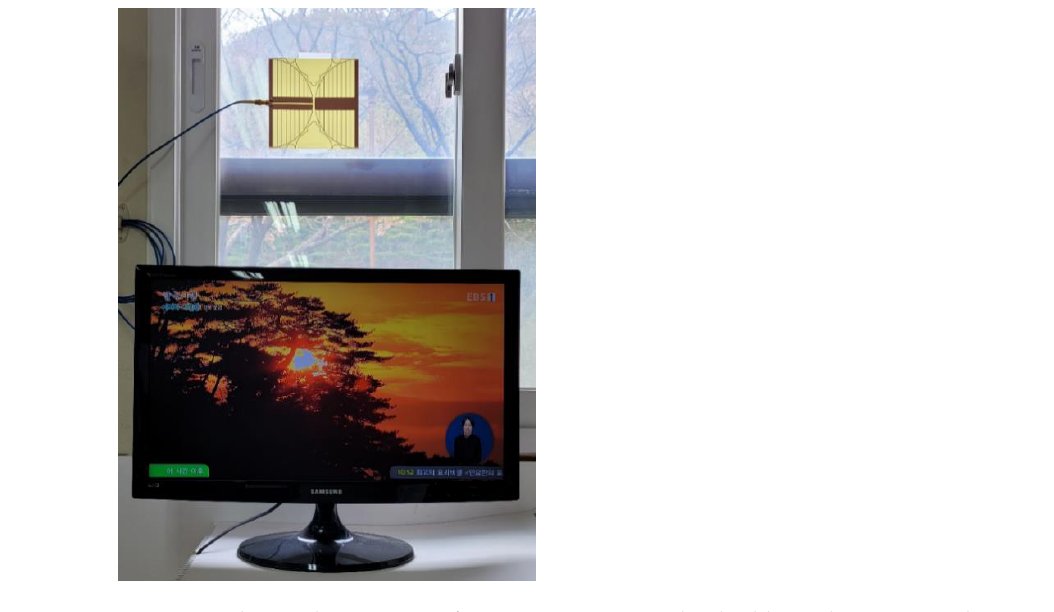
Figure 13. Measured radiation patterns of the fabricated antenna in the y – z and z – x planes at ( a ) 500 MHz; ( b ) 600 MHz; ( c ) 700 MHz.